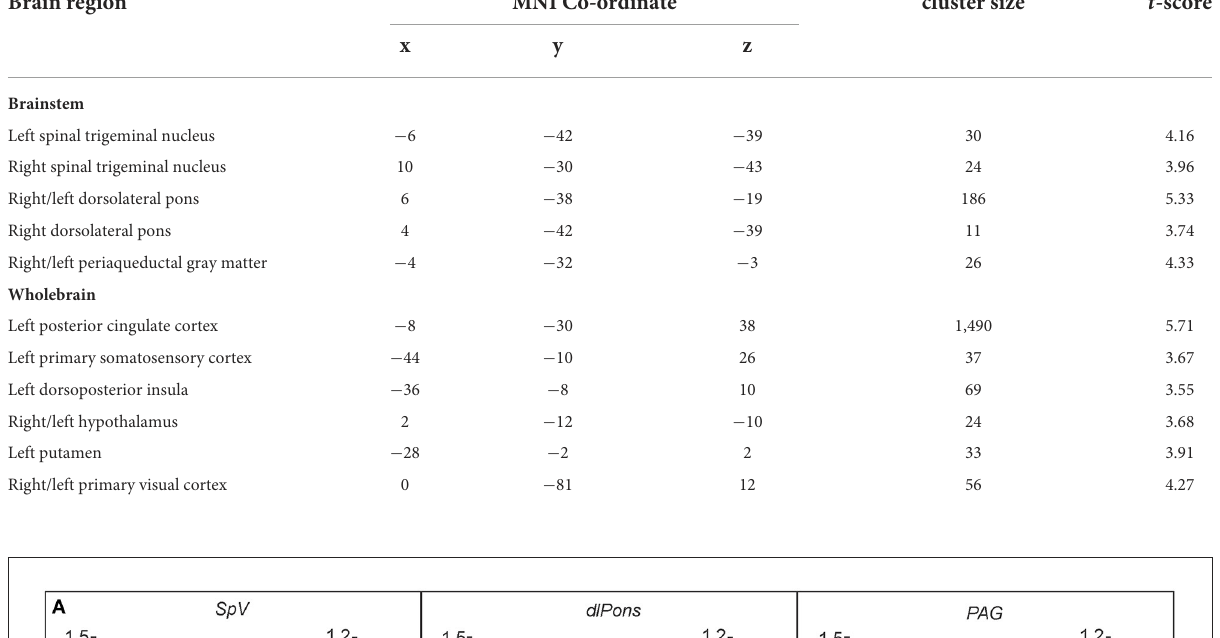
TABLE 1 Montreal Neurological Institute (MNI) coordinates, cluster size and t- score for regions in which decreasing trigeminal nerve fractional anisotropy was associated with increases in mean diffusivity in control and interictal migraine participants. Brain region MNI Co-ordinate